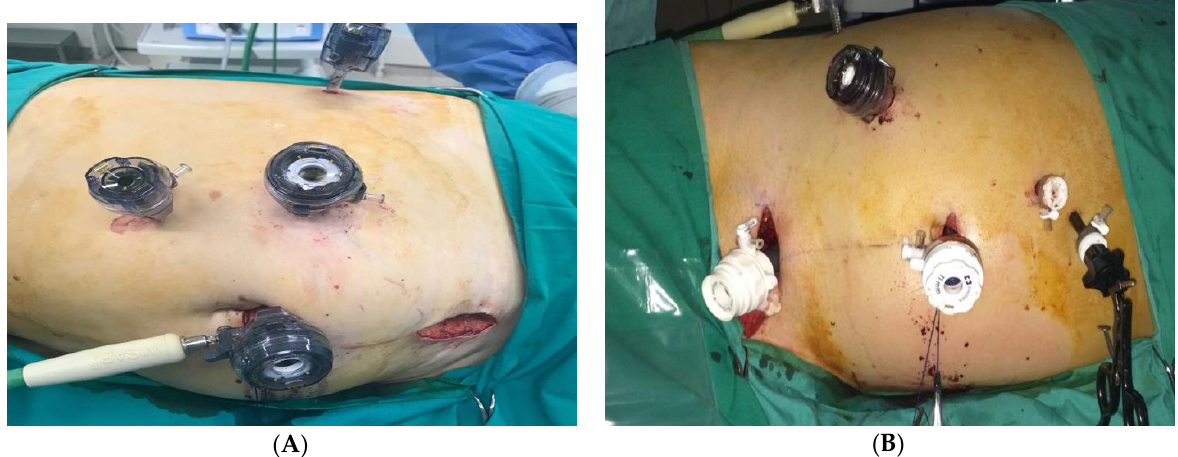
Figure 1. Port placement for laparoscopic donor nephrectomy (LDN). ( A ) Overview of the port placement for left-sided LDN. Four trocars. ( B ) Overview of the port placement for right-sided LDN. Five trocars.